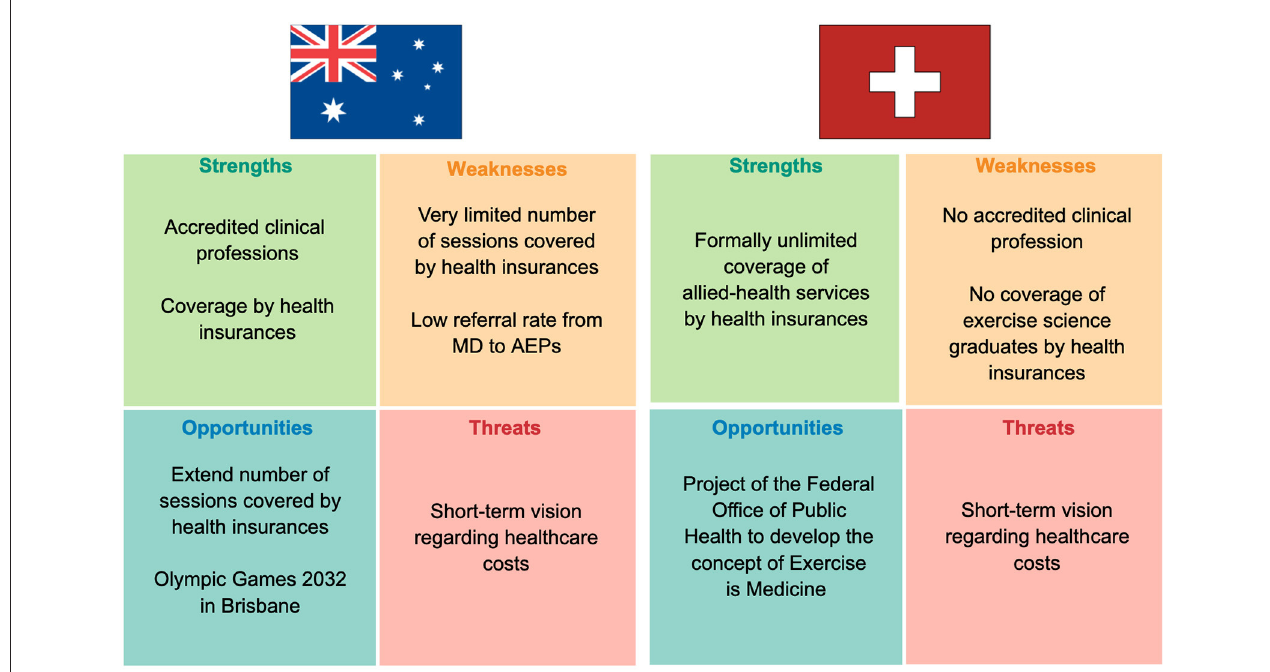
FIGURE 1 | Exercise science graduates in the Australian and Swiss healthcare systems: strengths, weaknesses, opportunities and threats analysis. MD, medical doctor; AEP, accredited exercise physiologist.